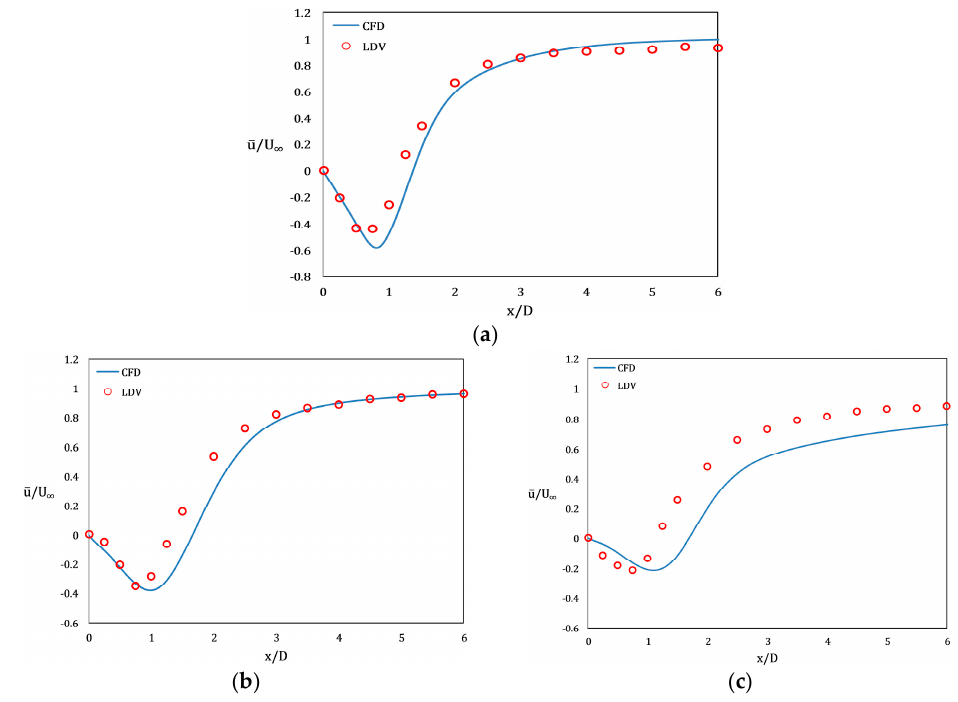
Figure 3. Wake centerline velocity at ( a ) z / D = − 0.5; ( b ) z / D = 0.0; and ( c ) z / D = 0.5. Table 2. Wake length behind the step cylinder.